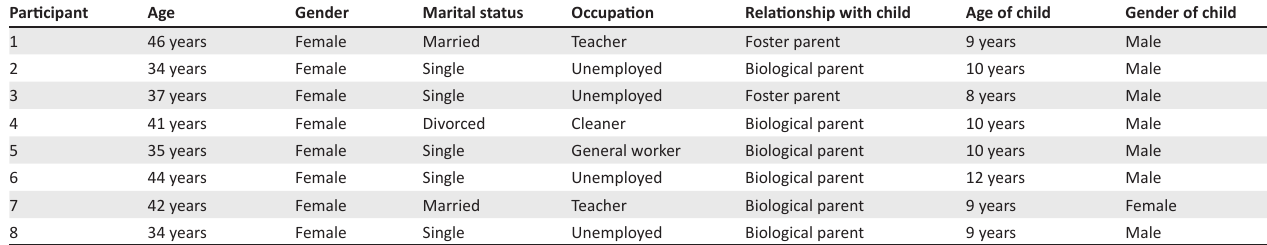
TABLE 1: Biographical profile of